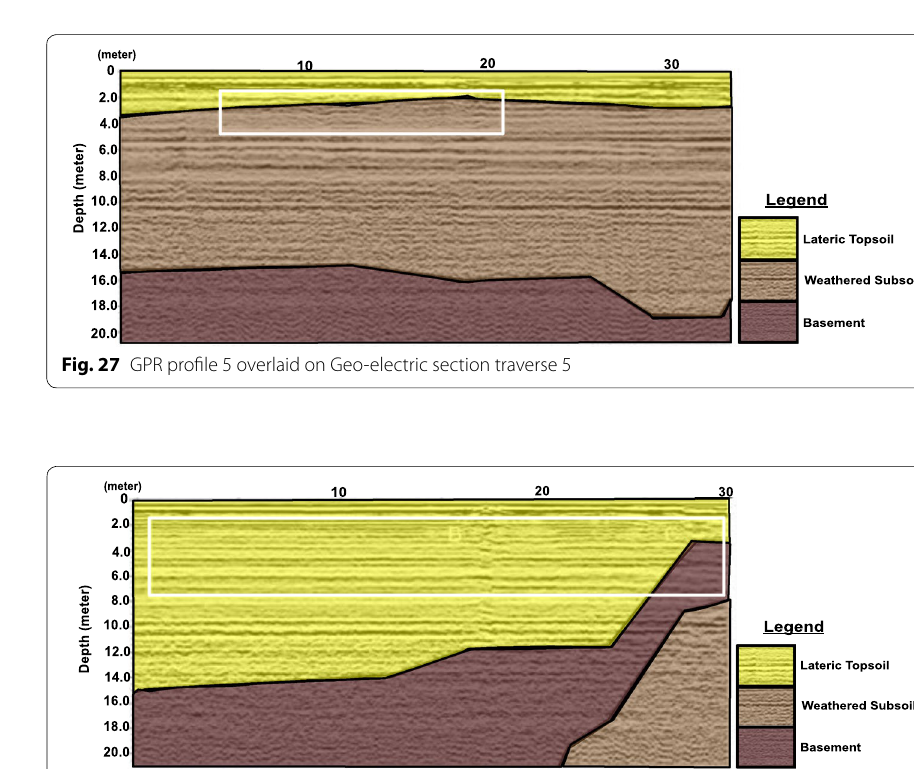
Fig. 28 GPR profile 6 overlaid on Geo-electric section traverse